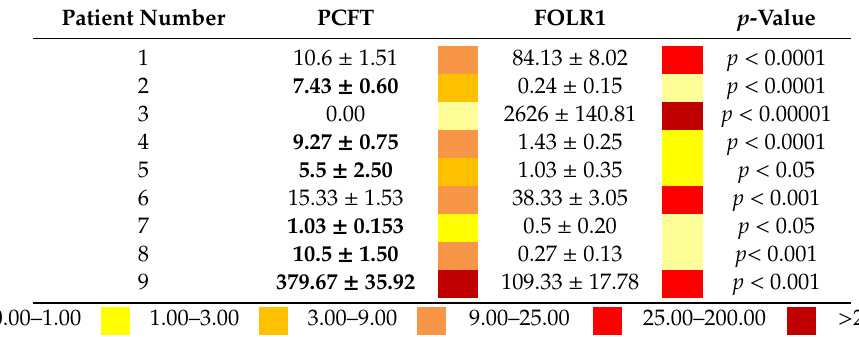
Table 1. Relative gene expression for proton-coupled folate transporter (PCFT) and folate receptor 1 (FOLR1) in human glioma cells purified from glioblastoma specimens. Data are normalized to glyceraldehyde 3-phosphate dehydrogenase (GAPDH) as housekeeping gene. Mean ± SEM and significant di ff erence between PCFT and FOLR1 gene expression in the specimen ( p ) are shown. The PCFT data highlighted in bold have values that are significantly up-regulated compared to the FOLR1 expression in the specimen ( p < 0.05). The color plot indicates the relative level of gene expression. Patient Number PCFT FOLR1 p